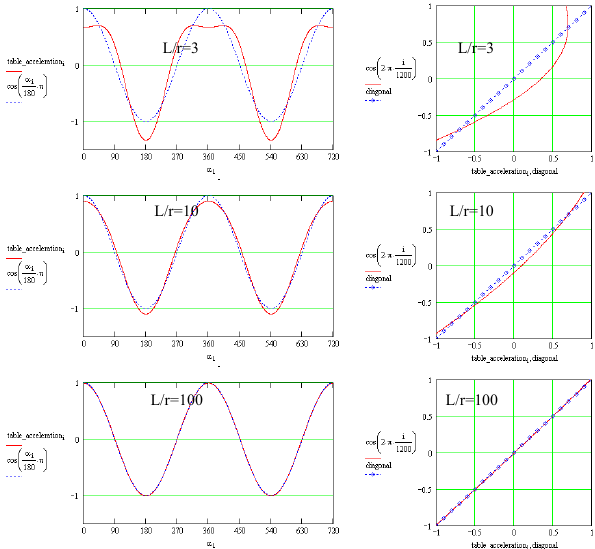
Fig. 4 Normalized shaking table acceleration comparison for different L/r ratios Fig. 4. Normalized shaking table acceleration comparison for dif- ferent L/r ratios.